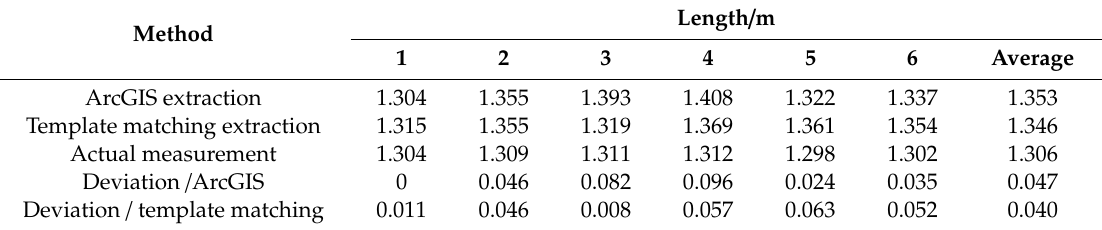
Table 6. Barrier boundary length obtained by di ff erent extraction